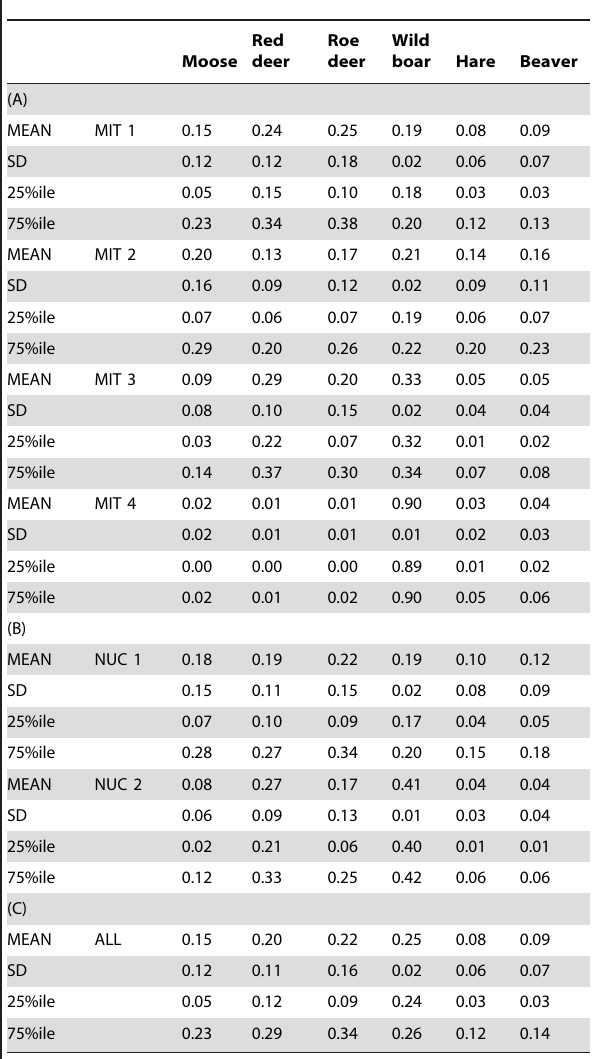
Table 3. Diet composition of wolves inferred from the stable isotope data using IsoSource for (A) subpopulations delimited based on mtDNA variability (MIT 1-MIT 4), (B) subpopulations delimited based on microsatellite variability (NUC 1, NUC 2), and (C) all individuals at